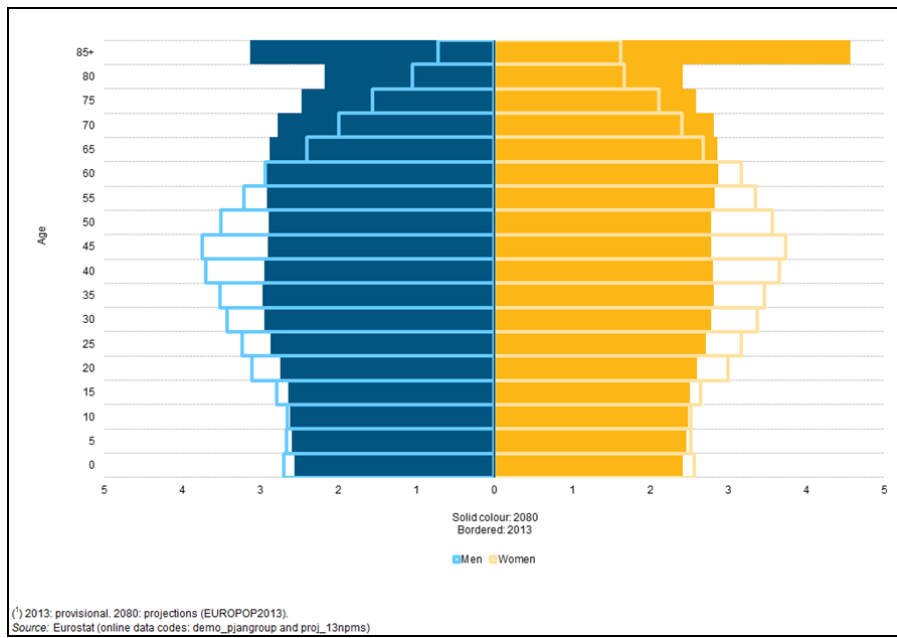
Figure 1. EU Population Pyramid (2013 and 2080 estimate).